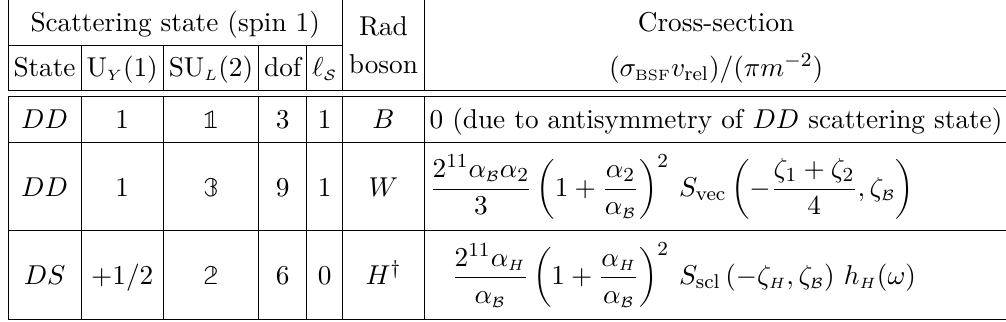
Table 9 . Same as table 7 for the DD bound states. Here, α and ω = m (cid:2) ( − α